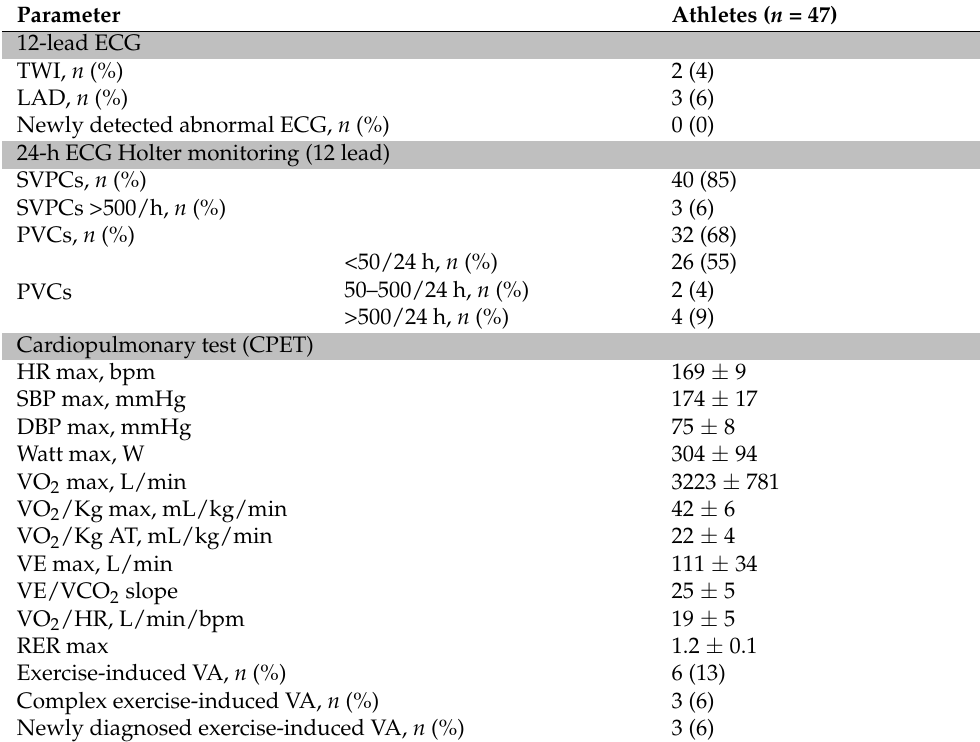
Table 2. Screening results: ECG, 24-h Holter monitoring, and